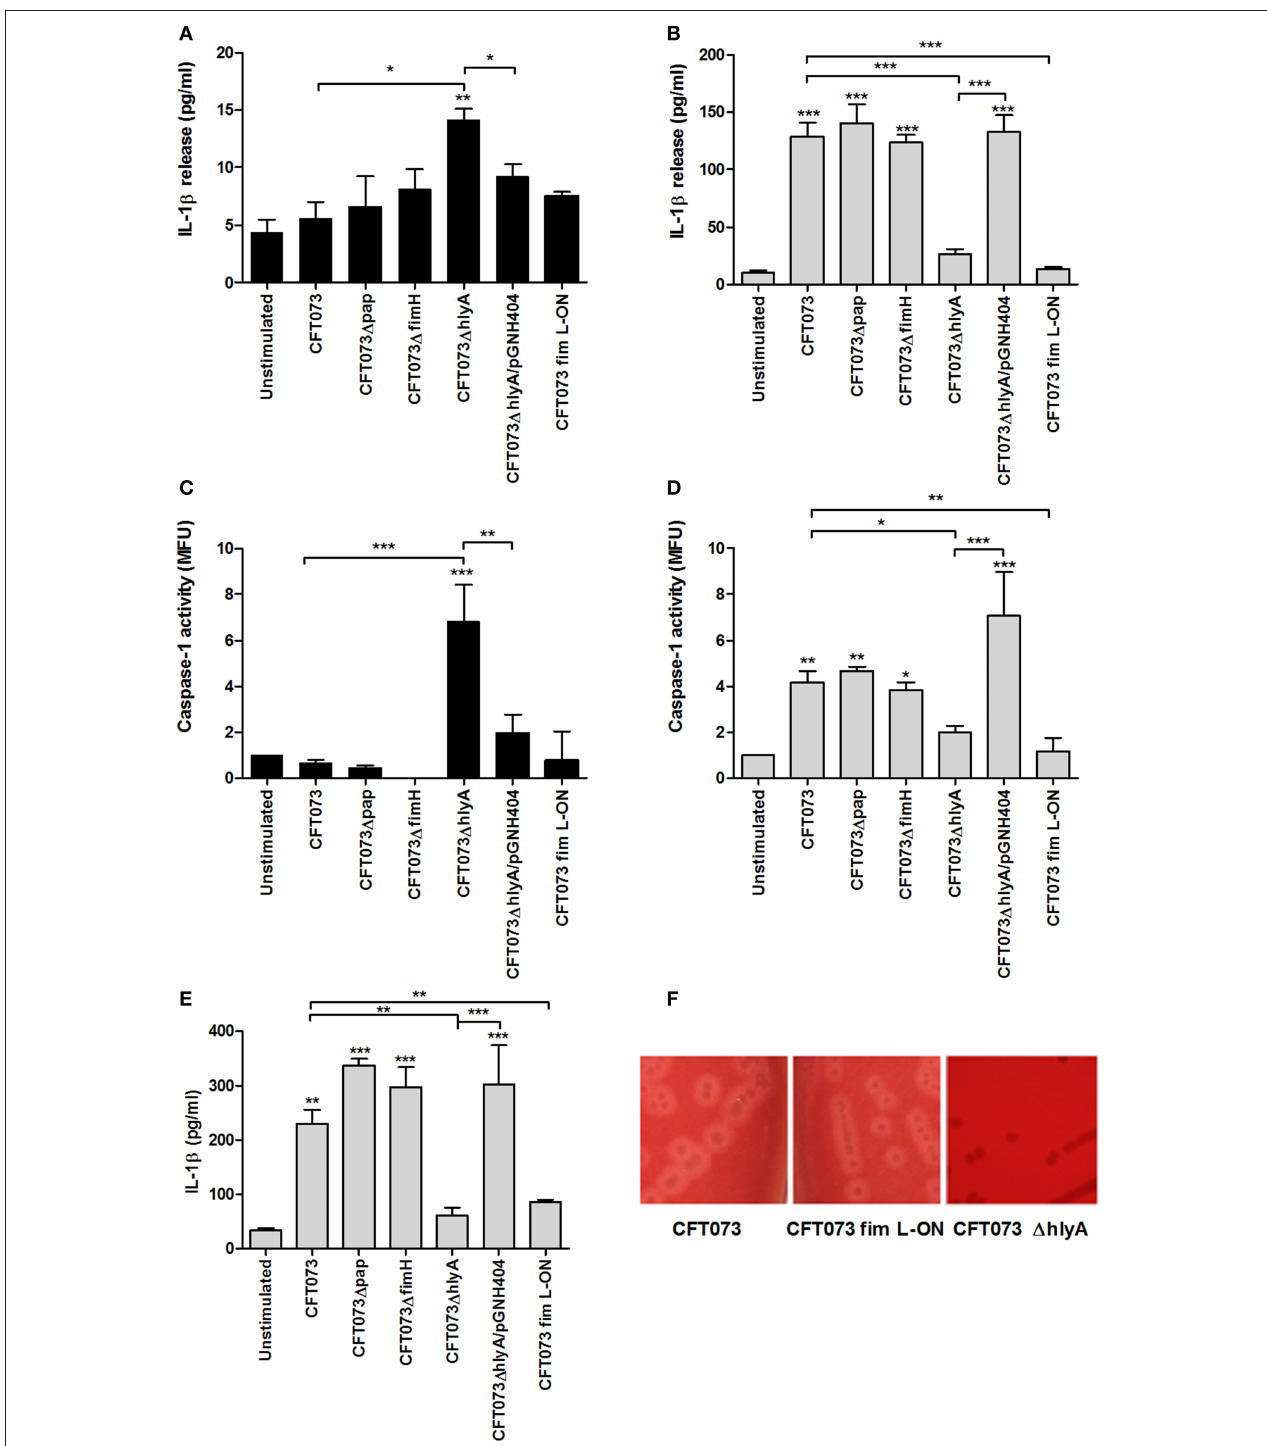
FIGURE 3 | The importance of different virulence factors for IL-1 β release and caspase-1 activity. The bladder epithelial cell line 5637 (A–D) and a spontaneously transformed bladder epithelial cell line HBLAK (E) were infected with CFT073, CFT073 1 pap, CFT073 1 fimH, CFT073 1 hlyA, CFT073 1 hlyA/pGNH404 and CFT073 fim L-ON at MOI 10 for 3 (A,C) and 6h (B,D,E) . IL-1 β release (A,B,E) and caspase-1 activity (C,D) were measured. Caspase-1 results are presented as fold increase of mean fluorescence units (MFU) compared to unstimulated control cells. Hemolysin activity on blood agar was evaluated for CFT073, CFT073 fim L-ON, and CFT073 1 hlyA after overnight incubation (F) . Data are presented as mean ± SEM ( n = 3 independent experiments). Asterisks denote statistical significance compared to respective unstimulated control (* p < 0.05, ** p < 0.01, *** p < 0.001).